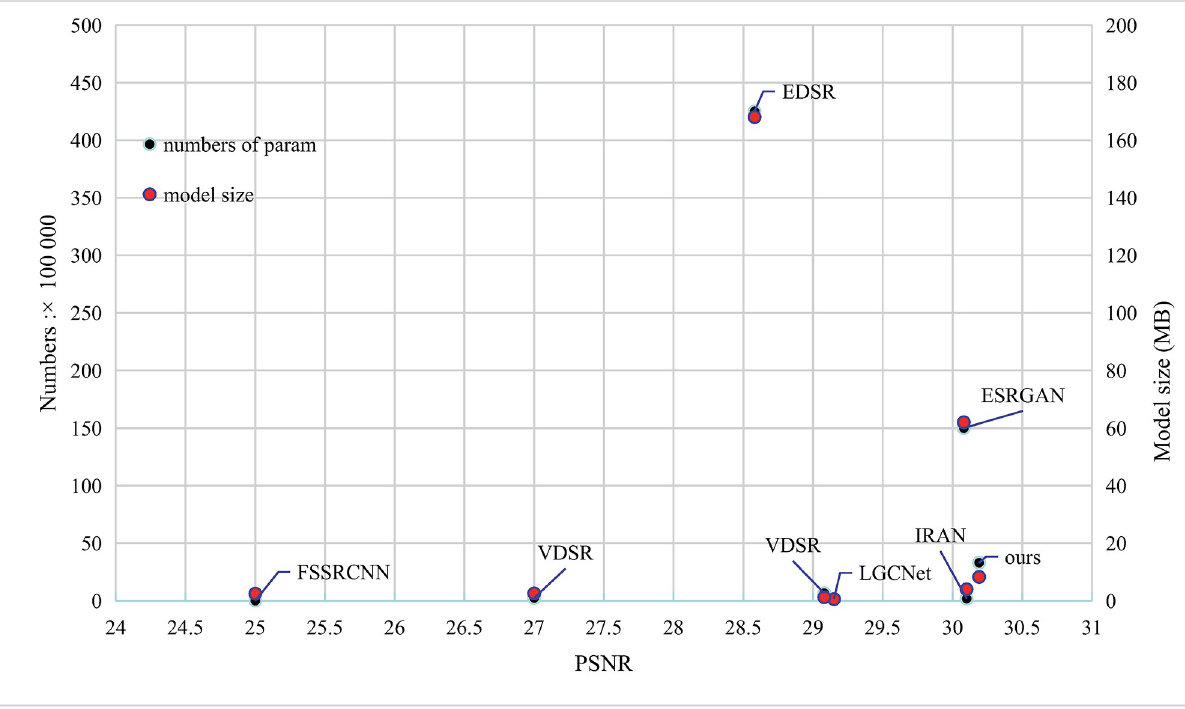
PLOS ONE | https://doi.org/10.1371/journal.pone.0276648 October 26,